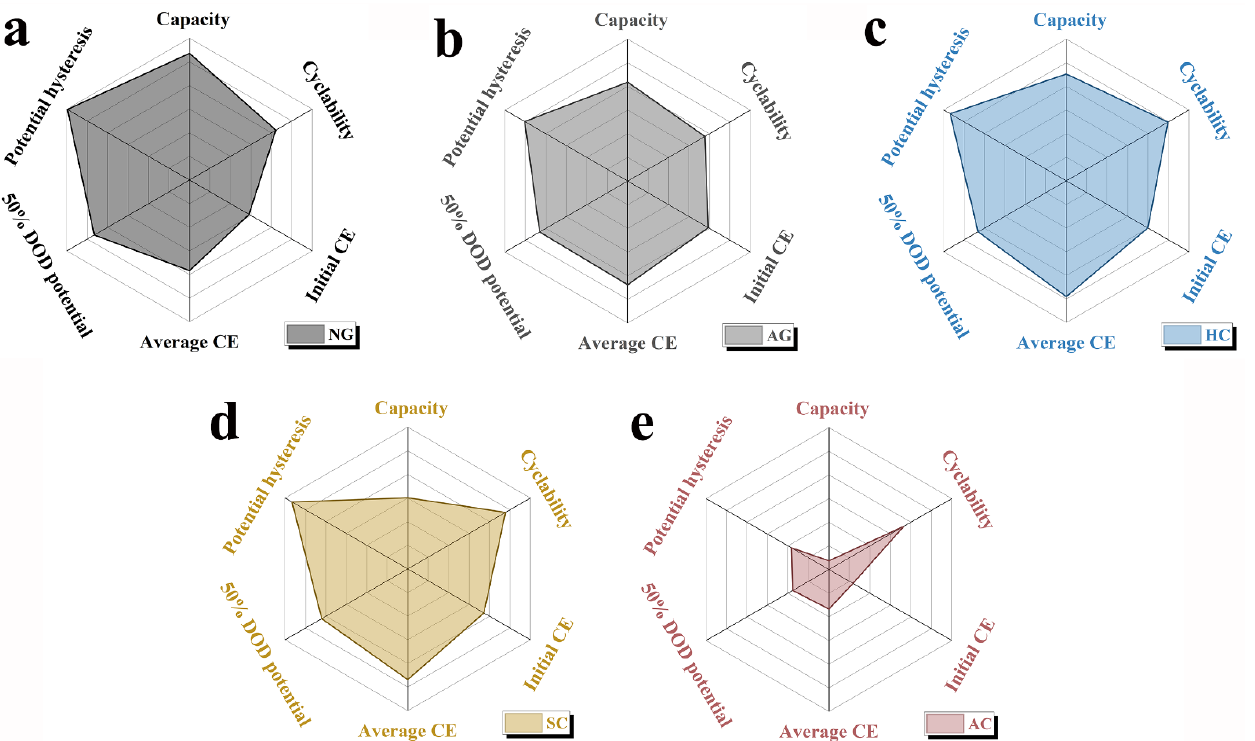
Figure 4. A comparative summary considering critical parameters toward practical PIBs. ( a ) NG, ( b ) AG, ( c ) HC, ( d ) SC, and ( e ) AC.